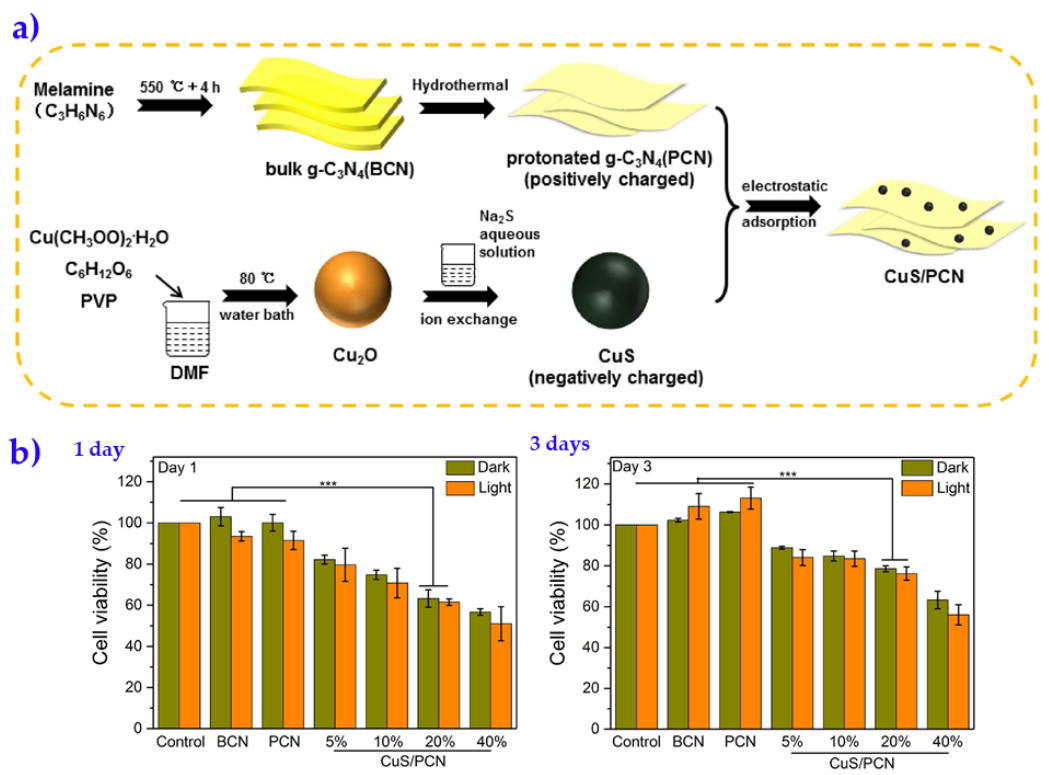
Figure 6. ( a ) Synthesis of CuS/protonated g-C 3 N 4 composites, and ( b ) their effect on the cell viability as a function of the composite loading. Adapted from Ding et al. [71] .